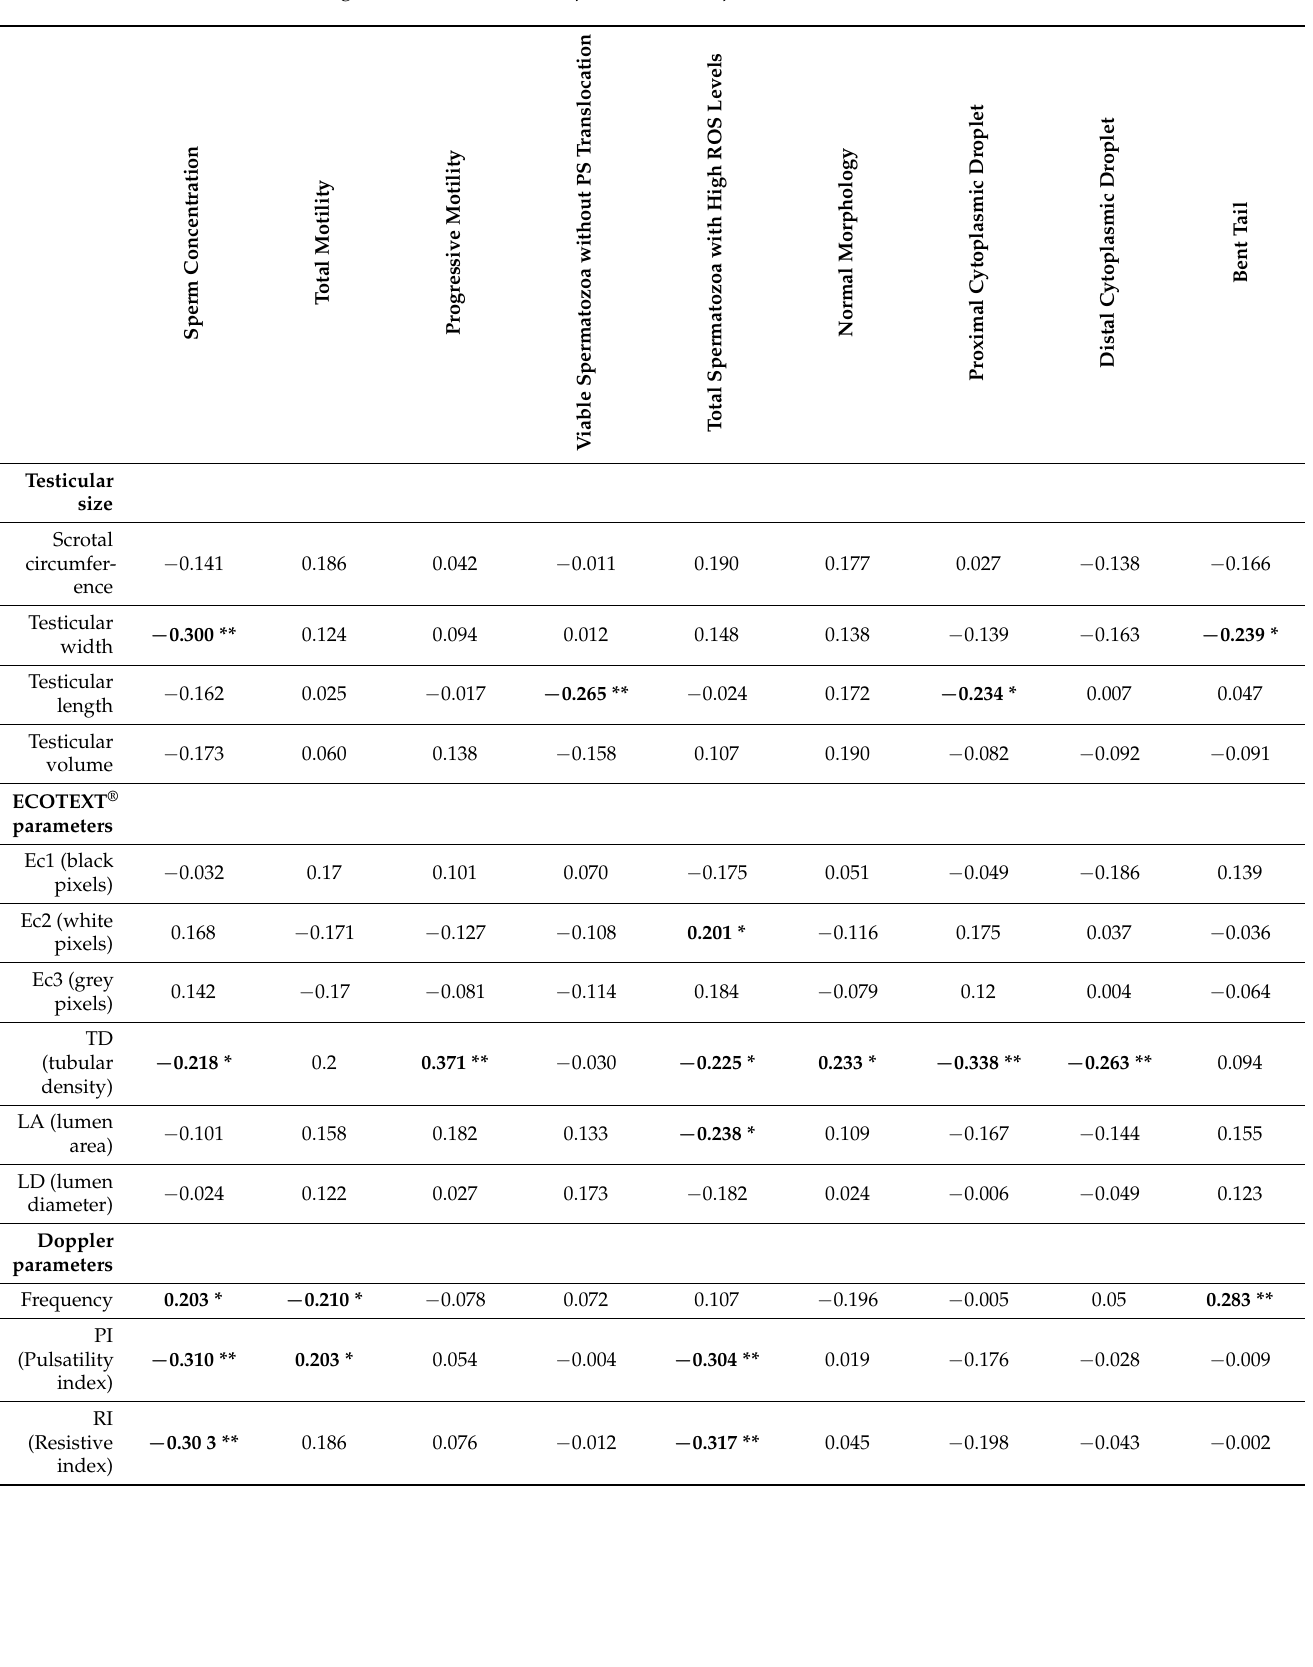
Table 3. Spearman’s rank correlation coefficient (Spearman’s ρ ) between testicular size, echotexture parameters (evaluated by ultrasound-video analysis and ECOTEXT ® software) or testicular-artery blood flow (assessed by color-Doppler flow imaging) and some sperm parameters, analyzed the same day of the testes evaluation, in Rasa Aragonesa rams ( n = 96). Bold type indicates statistically significant correlations. * p < 0.05 and ** p <